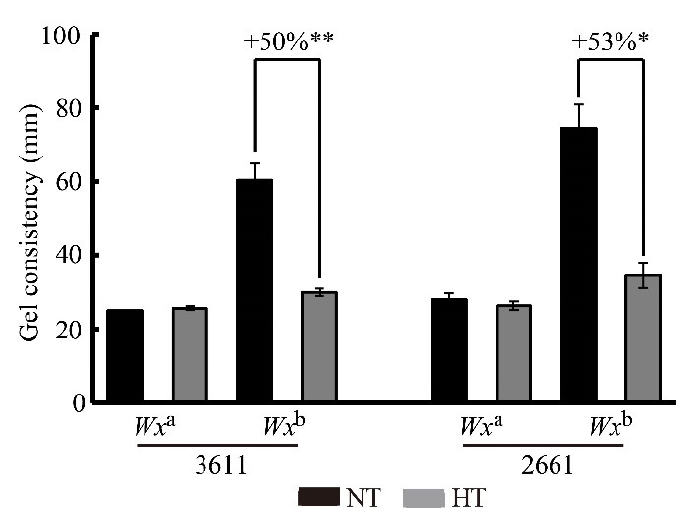
Figure 7. The influence of high temperature on the gel consistency of the mature seed flour from different Wx NILs. “NT” stands for normal condition and “HT” stands for high-temperature condition. Double asterisks denote a highly significant difference using Student’s t -test ( p < 0.01). A single asterisk denotes a significant difference using Student’s t -test (0.01 < p < 0.05). All significant- difference analyses were performed between the same samples at different temperatures.